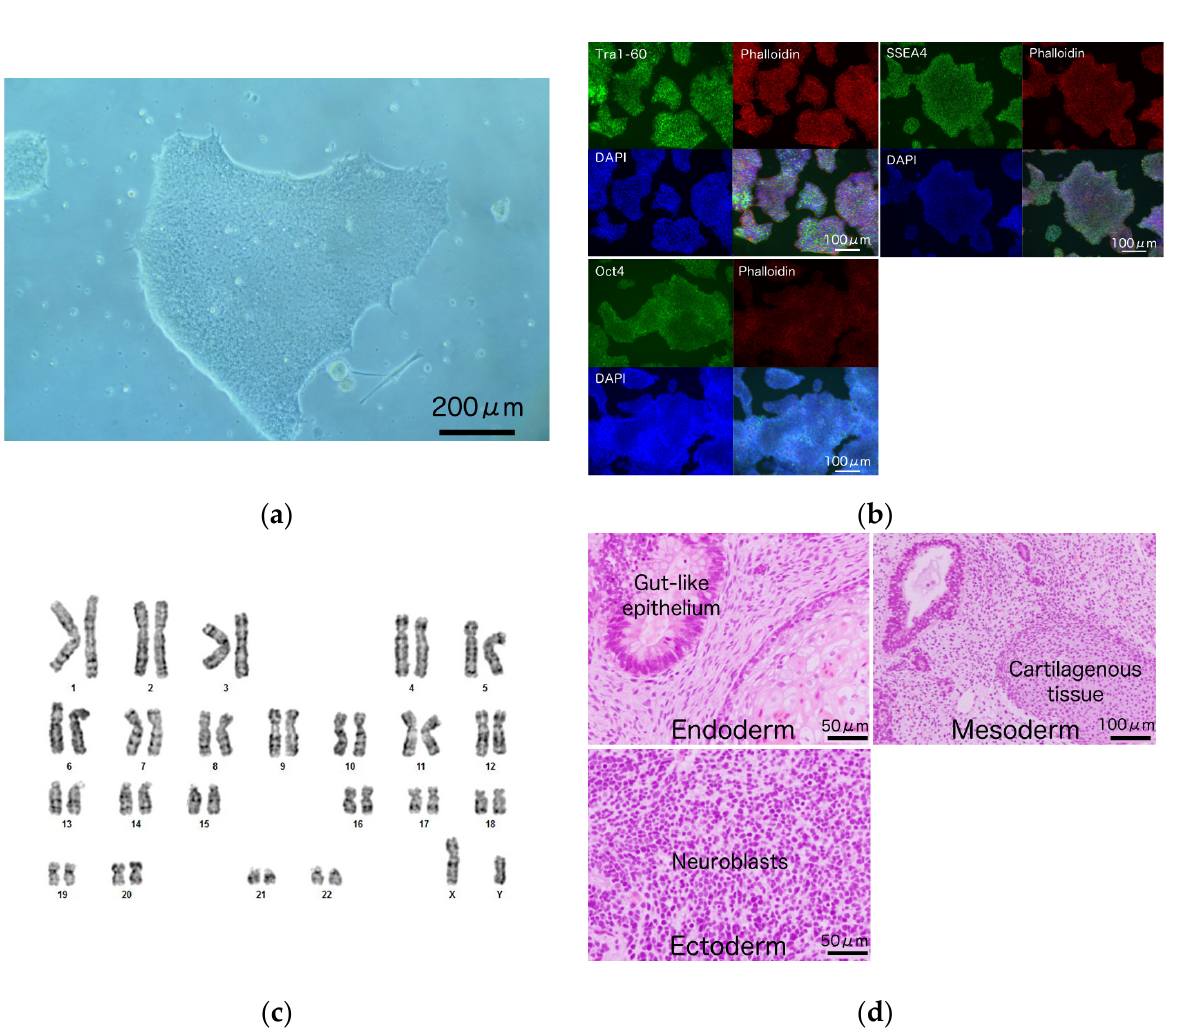
Figure 2. Characterization of induced pluripotent stem cell (iPSC) from a patient with Nav1.5 R1623Q mutation. ( a ) iPSC colonies derived from the lymphoblastoid cell lines (LCLs) of a patient with Nav1.5 R1623Q mutation. Scale bar = 200 µ m. ( b ) The expression of the pluripotency markers TRA-1-60, SSEA4, and OCT4 in R1623Q mutation-harboring iPSC colonies was analyzed using immunostaining. Scale bars = 100 µ m. ( c ) Karyotype of the iPSCs harboring R1623Q mutation was normal. ( d ) Teratomas were prepared from iPSCs harboring the R1623Q mutation. The tissues from all three germ layers were detected in the teratoma. Scale bars = 50 µ m for ‘endoderm’ and ‘ectoderm’; 100 µ m for ‘mesoderm’.